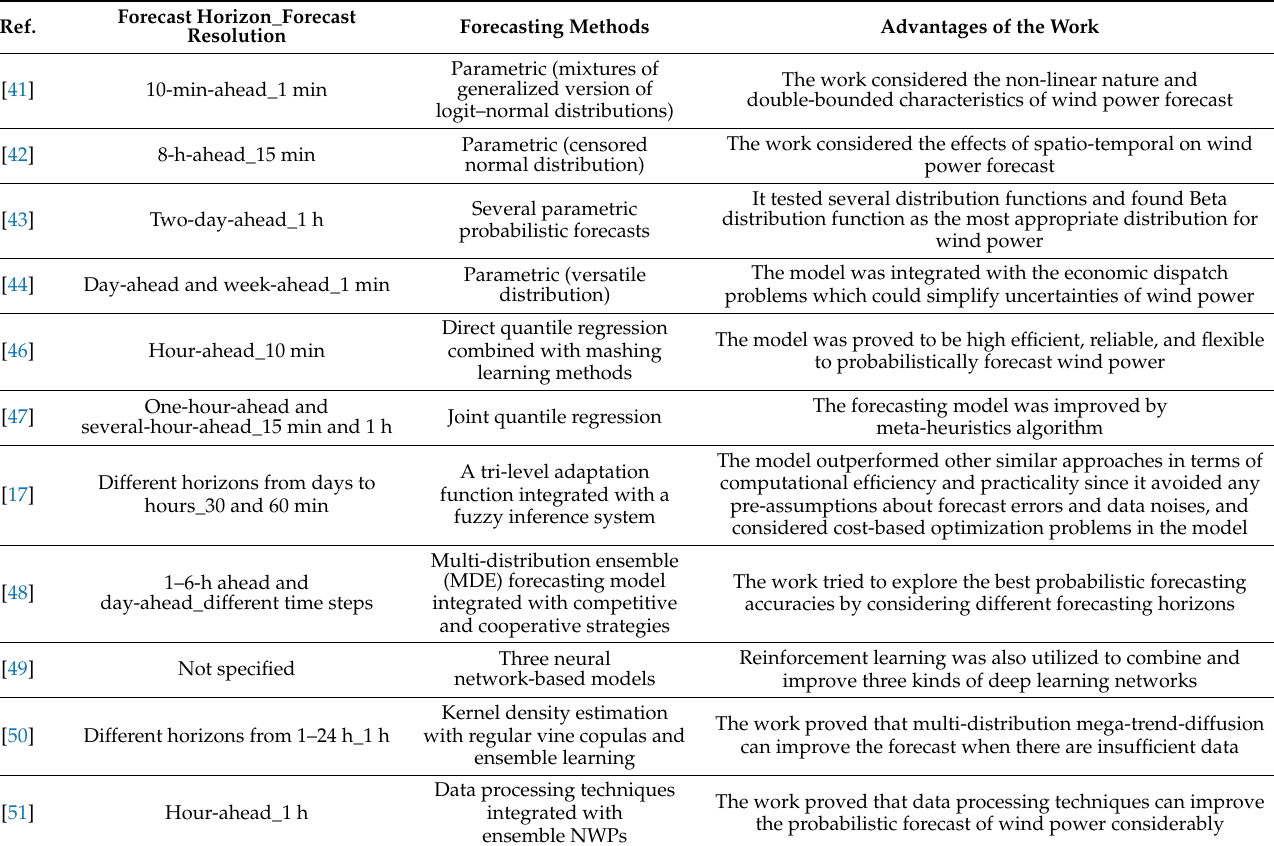
Table 3. An overview of selected papers developing probabilistic forecasting models for wind